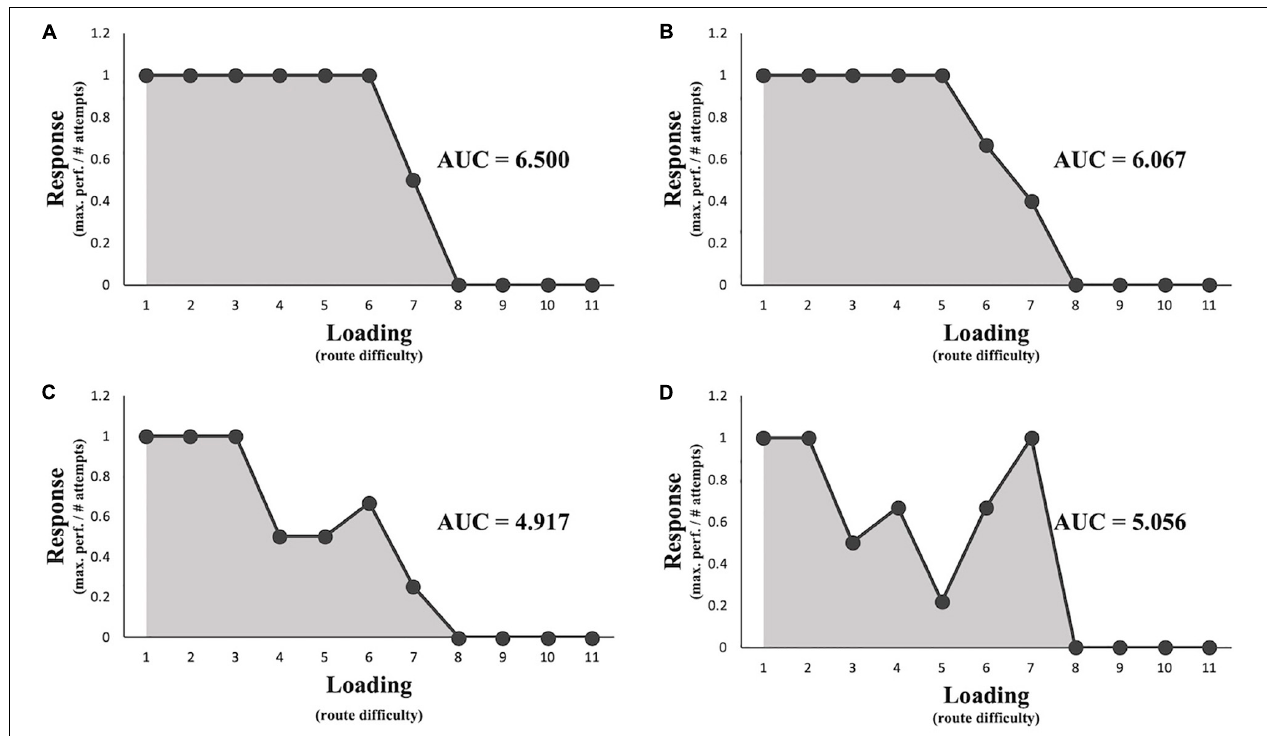
FIGURE 4 | Four examples of different athletes’ load–response curves reaching the same maximum performance level (A–D) . The curves are created by mapping the response scores (see Eq. 1) as a function of loading determined by routes ordered from easiest (1) to most difficult (11). The gray area under the curve (AUC) score (i.e. the sum of an individual’s response scores, see Eq. 2) represents an athlete’s phenotypic plasticity